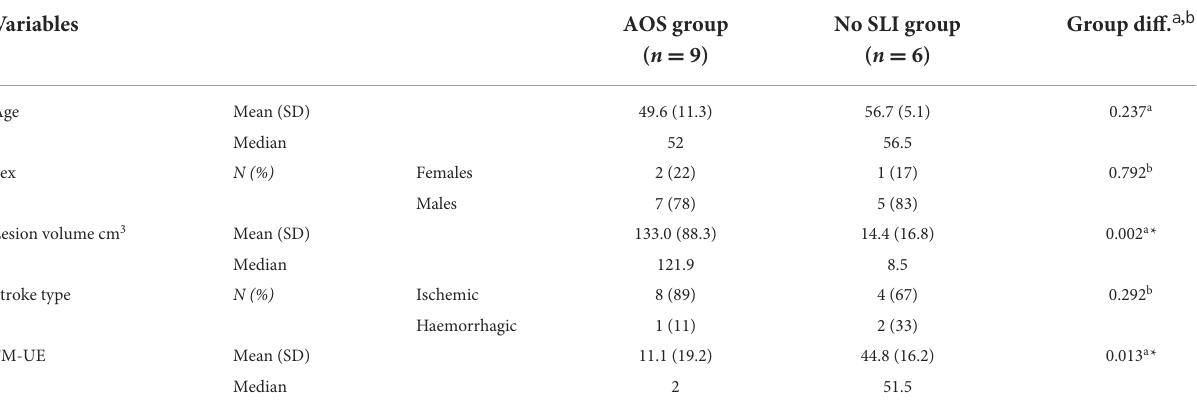
TABLE 3 Demographic and clinical characteristics at the first